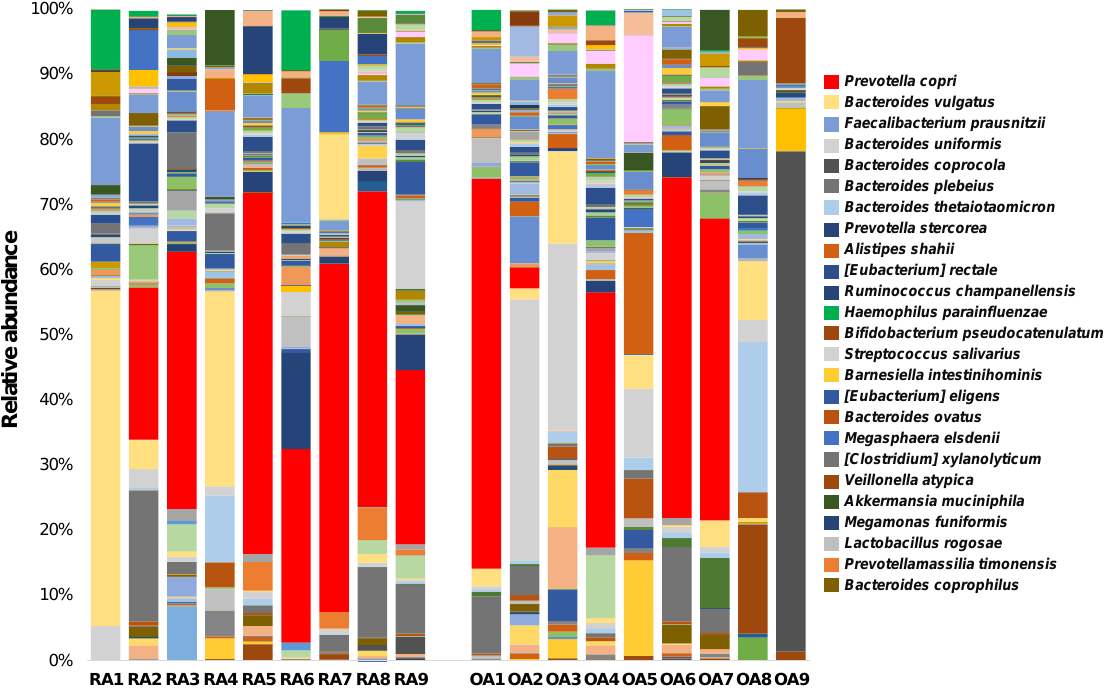
Figure 5. Stacked bar graphs for the relative abundance of bacterial 16S rRNA from fecal samples of rheumatoid arthritis (RA1–9) and osteoarthritis (OA1–9) patients at the species level. Legend on the right side represents the 25 most abundant species arranged